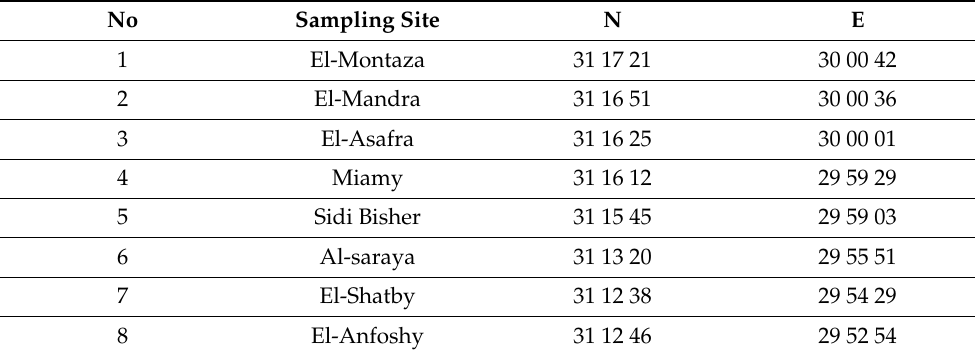
Table 1. Sampling sites description.